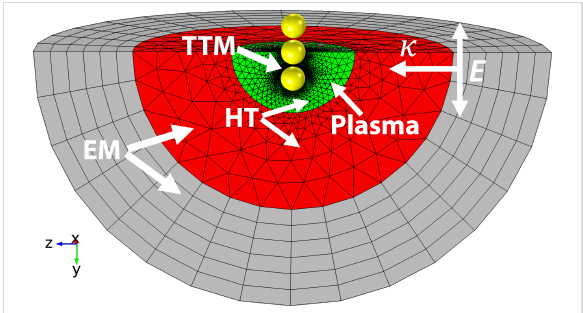
Figure 1: Schematic of the model geometry for a nanosphere trimer. The model contains three concentric domains. The most outer domain (grey) represents a combination of a perfectly matched layer (PML) domain and an absorbing boundary condition to truncate the electro- magnetic domain and reduce reflections from artificial boundaries. The red and green domains represent an aqueous environment with dielec- tric and physical properties of water. The green domain is used to calculate the plasma formation, and the green and red domains are used to calculate the heat transfer in the medium. The yellow domain shows the gold nanostructure geometry. The incident electric field is linearly polarized along the nanosphere trimer length ( y -axis) and prop- agates parallel to the positive z -axis.